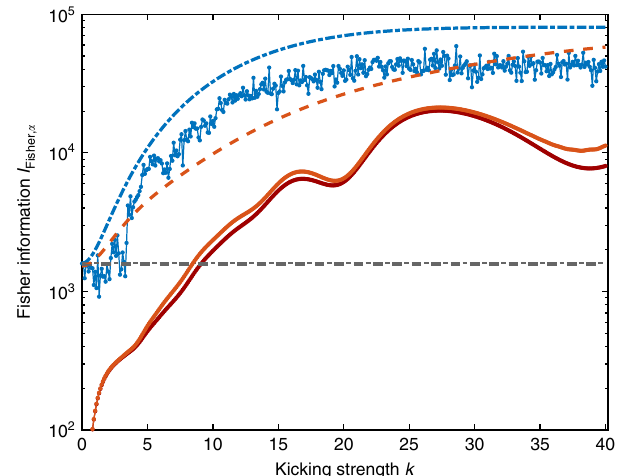
Fig. 8 Performance of an exemplary spin-component measurement with superradiance damping. Fisher information I Fisher, α related to measuring the y -component of the spin, J y , after t = 2 time steps without dissipation (blue line) as well as in the presence of dissipation (bright red line, damping constant γ = 0.5 × 10 − 3 ), upper bounded by corresponding quantum Fisher informations (blue dash-dotted and red dashed lines), for spin size j = 200, and an initial state at ( θ , ϕ ) = ( π /2, π /2). For the dissipative case, Fisher information with a 5% uncertainty in the kicking strength is given by the dark red line slightly below the bright red line. Horizontal gray lines represent benchmarks (kicking strength k = 0) for t = 2 optimized over initial states (dashed with dissipation and dash-dotted without; lines are almost on top of each other). In both cases the benchmark is clearly outperformed for k ≳ 3.5 and k ≳ 10.6 without and with